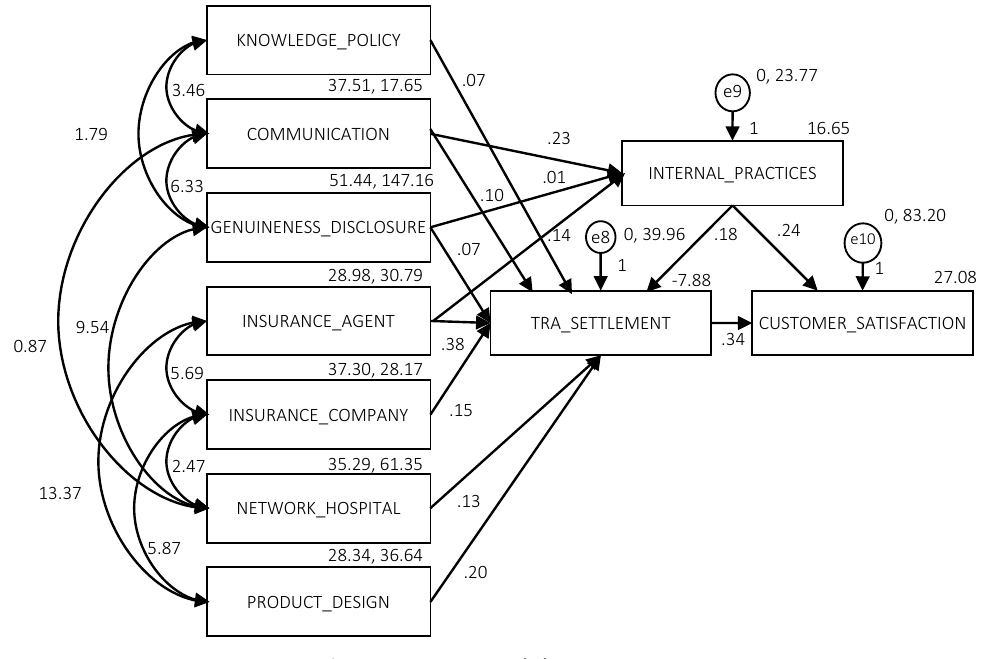
Figure 3. SEM model option-1